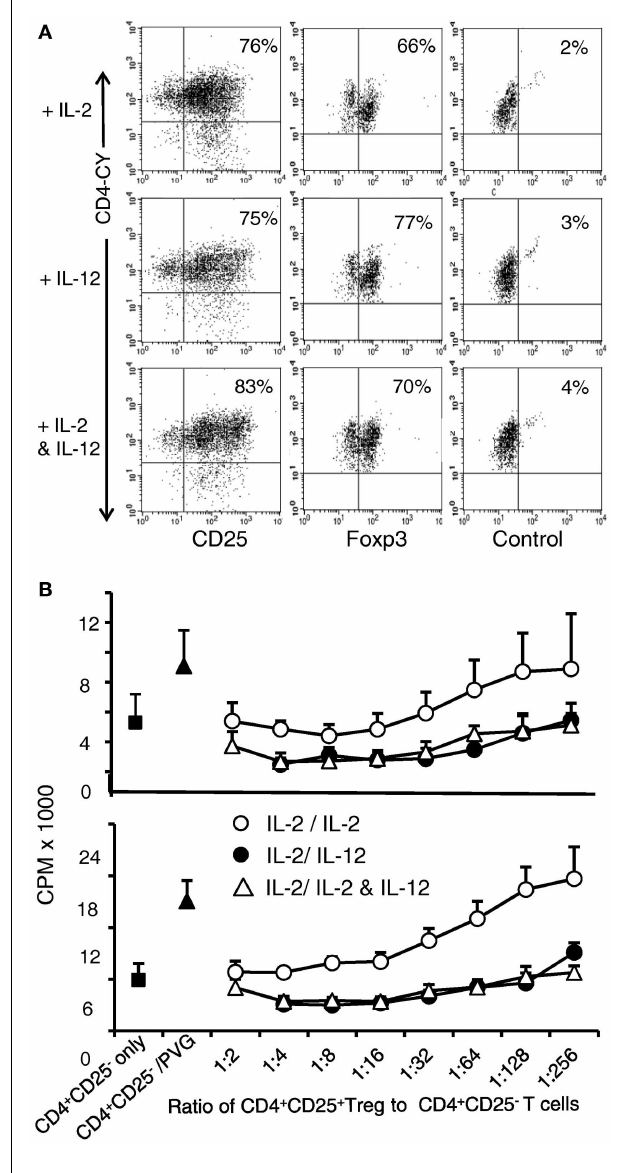
FIGURE 3 | Examination of phenotype and suppressive ability ofTs1 cells re-cultured with rIL-12p70 alone or in combination with IL-2 .Ts1 cells were washed and re-cultured with alloantigen and either rIL-2 alone, rIL-12p70 alone, or both rIL-2 and rIL-12p70 for 4days before examination of: (A) CD25 and Foxp3 expression. All three cultures showed that a large proportion of cells were CD25 high and 70–80% expressed Foxp3. (B) Suppressive ability. Cells from all three cultures were tested for ability to suppress naive CD4 + CD25 − T cell proliferation in MLC against PVG (top panel) or third party Lewis (lower panel) stimulator cells. A constant number (1 × 10 5 ) of naïve CD4 + CD25 − T cells were cultured with serial dilutions of re-culturedTs1 cells.Ts1 re-cultured with PVG alloantigen and either rIL-12p70 ( • ) or rIL-2 and rIL-12p70 ( (cid:52) ) had greater suppression compared to those re-stimulated with IL-2 alone ( ◦ ). Proliferation was suppressed to or below background levels observed with naïve CD4 + CD25 − T cells cultured alone (5.0 ± 1.2 × 10 3 cpm) or with syngeneic DA stimulator cells (5.1 ± 2.0cpm).Ts1 re-cultured with rIL-12p70 showed significant suppression at all dilutions ( p < 0.001).Ts1 cells re-cultured with alloantigen